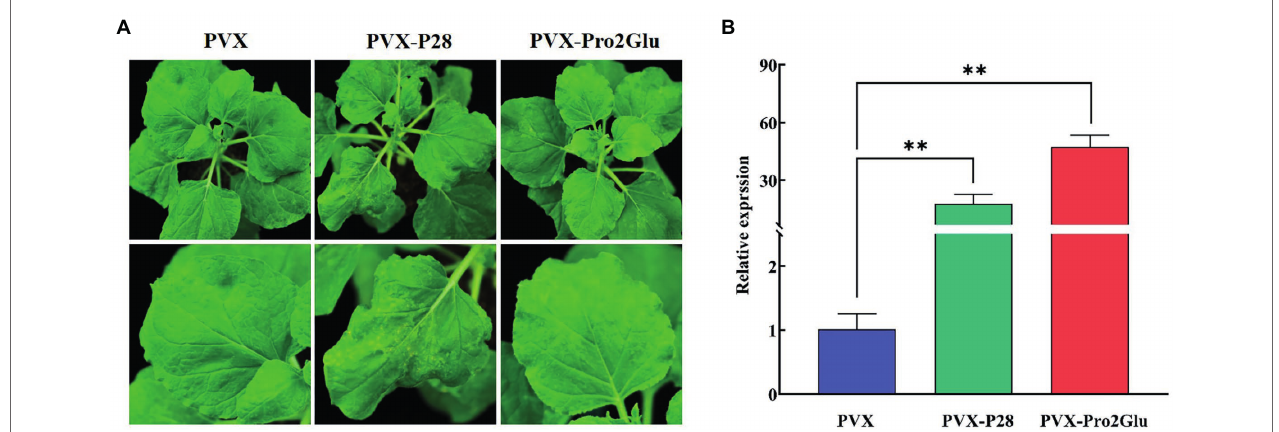
FIGURE 6 | Pro2Glu and P28 enhanced the pathogenicity of potato virus X (PVX) in N. benthamiana plants. (A) The symptoms on N. benthamiana systemic leaves infiltrated by pGR106 empty vector (PVX), PVX-P28 or PVX-Pro2Glu at 22 dpi. (B) The relative expression of PVX in N. benthamiana systemic leaves at 22 dpi as determined by RT-qPCR. The error bars indicate standard error, n = 3. Differences between PVX and PVX-P28 or PVX-Pro2Glu are analyzed by one-way ANOVA and Tukey’s test ( p < 0.05), ** p <